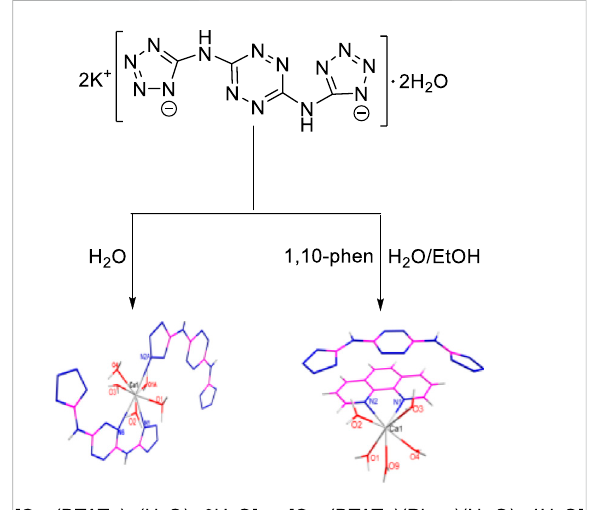
FIGURE 4 Synthetic route for [Ca 2 (BTATz) 2 (H 2 O) 8 · 6H 2 O] and